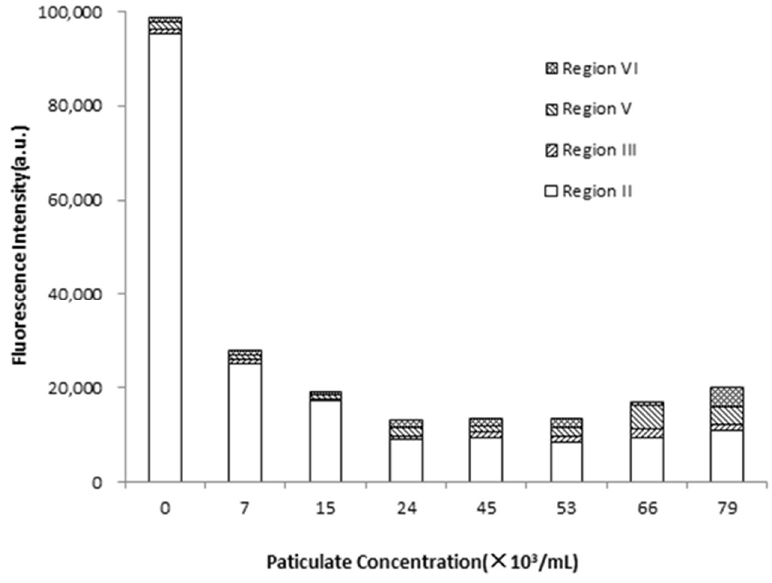
Figure 4. Impact of particle concentration on the fluorescence intensity of EPS.